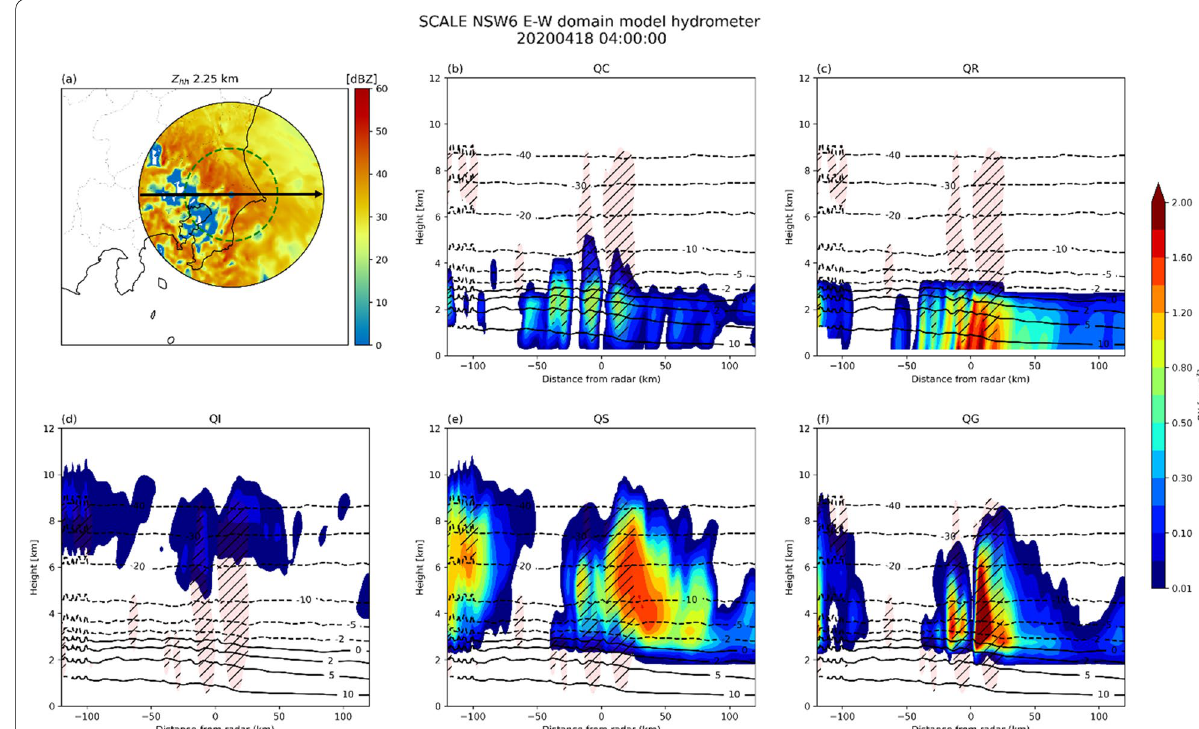
Fig. 21 The same as Fig. 10, but for the SCALE-NSW6 simulation